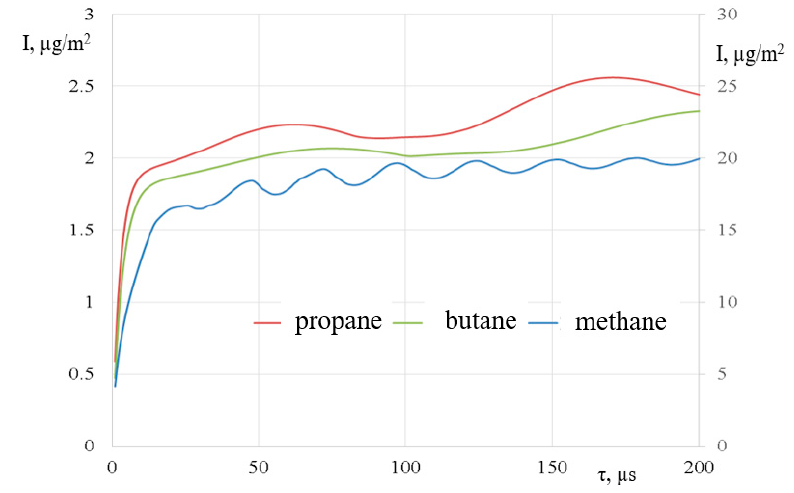
Figure 12. Hydrate specific amount (methane-right axle, propane and isobutane-left).